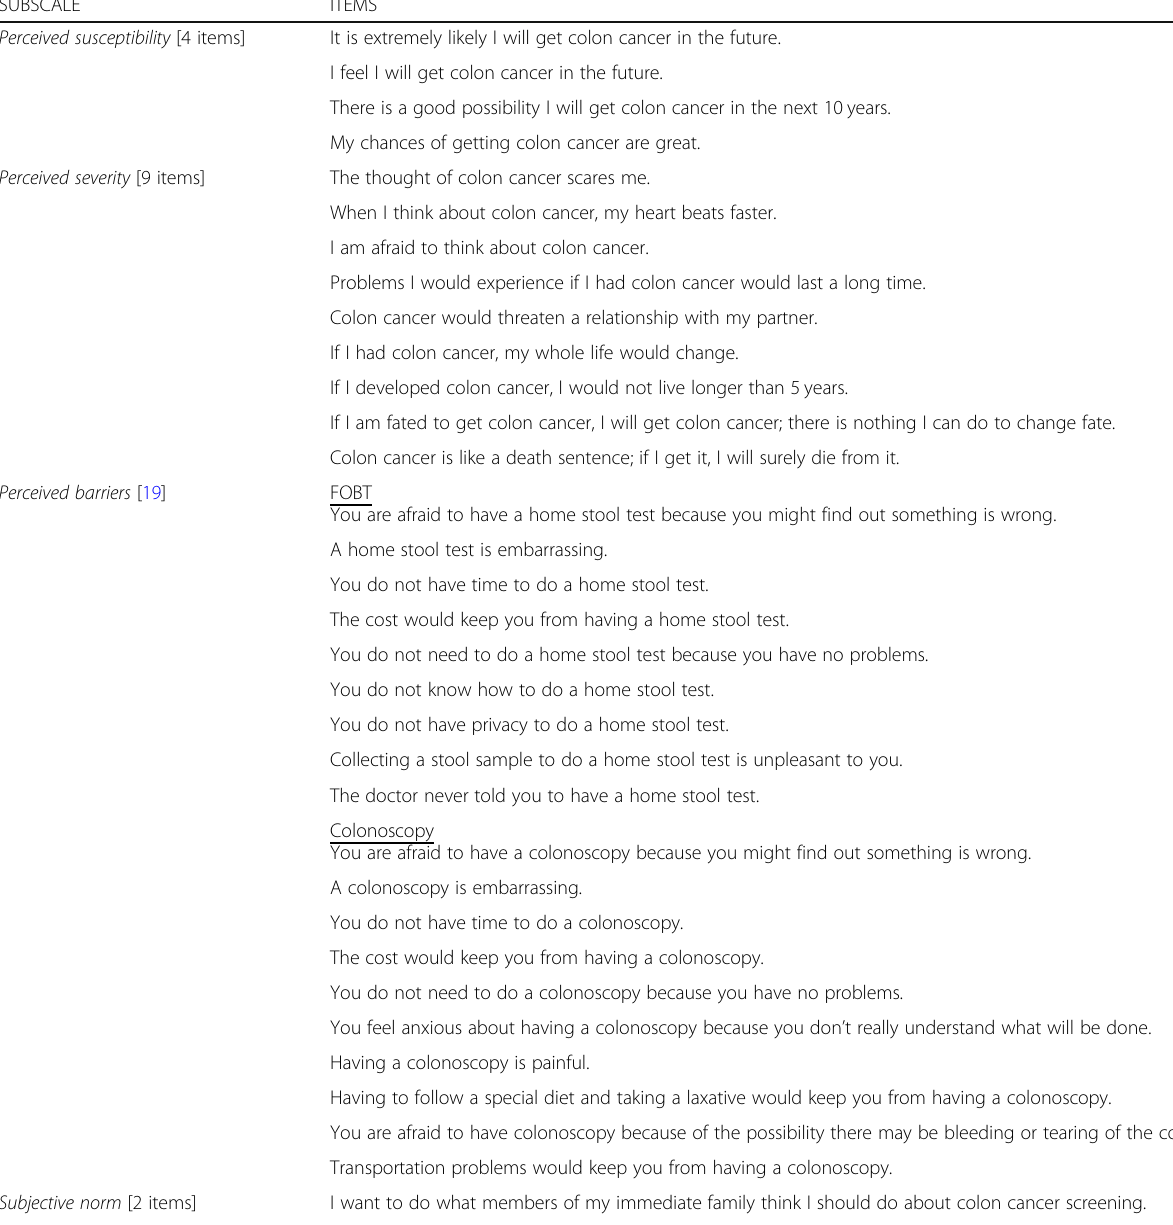
Table 6 Retained items in 4 subscales SUBSCALE